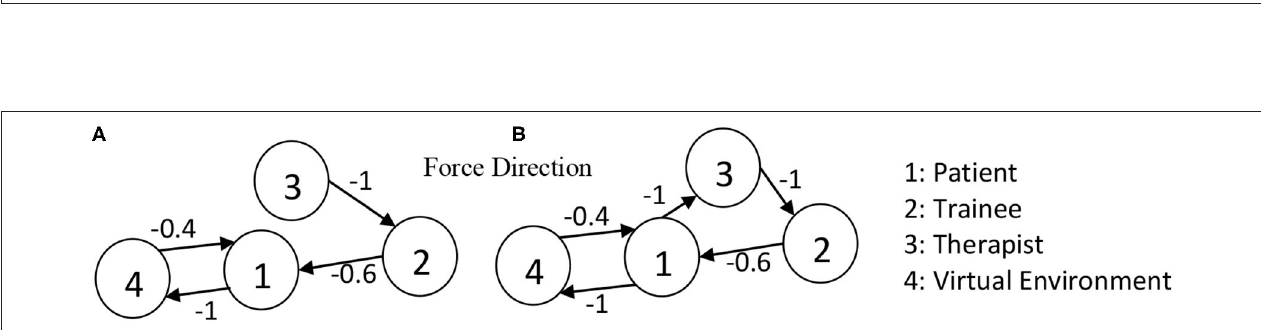
FIGURE 10 | Desired graphs, considered for the proposed system in sections 6.1 and 6.4. This diagram is equivalent to the D matrices in (47) and (49) in which, the circles represent the role of each user. Next to the diagram, meaning of the numbers inside each circle is written. Moreover, on the arrows in the diagram, numbers are written that are equal to the numbers expressed in the rows of the D matrices of (47) and (49). Part (A) shows the force graph of HTS. It is the graph of matrix D in (47). Part (B) depicts the force graph of the proposed SMT. It is the graph of matrix D in (49).